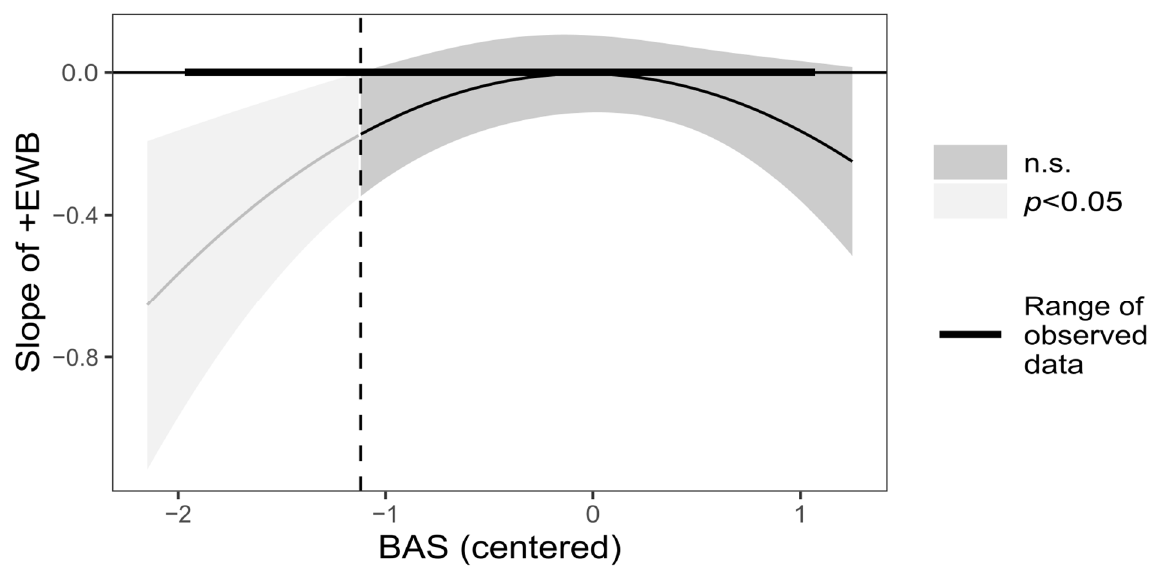
Figure 6. Graphic representation of BAS (Beliefs about stress) moderation on the relationship between +EWB (Positive experienced well-being) and anxiety symptoms.